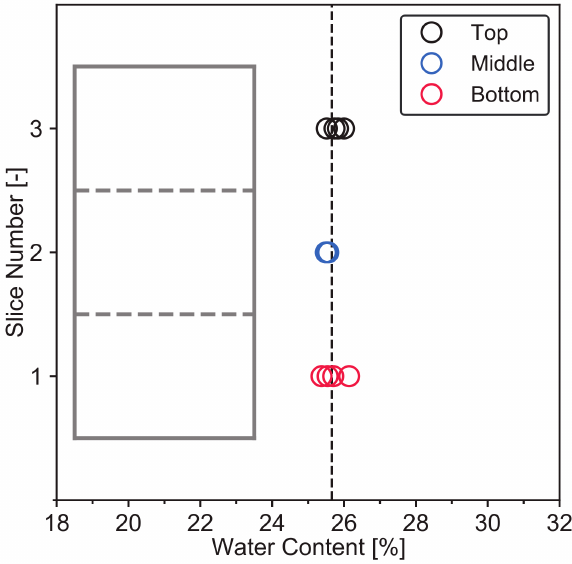
Figure 6. Water content ( w ) at different layers of the sand–clay mixture sample after S1 preconsolida- tion (75% K clay